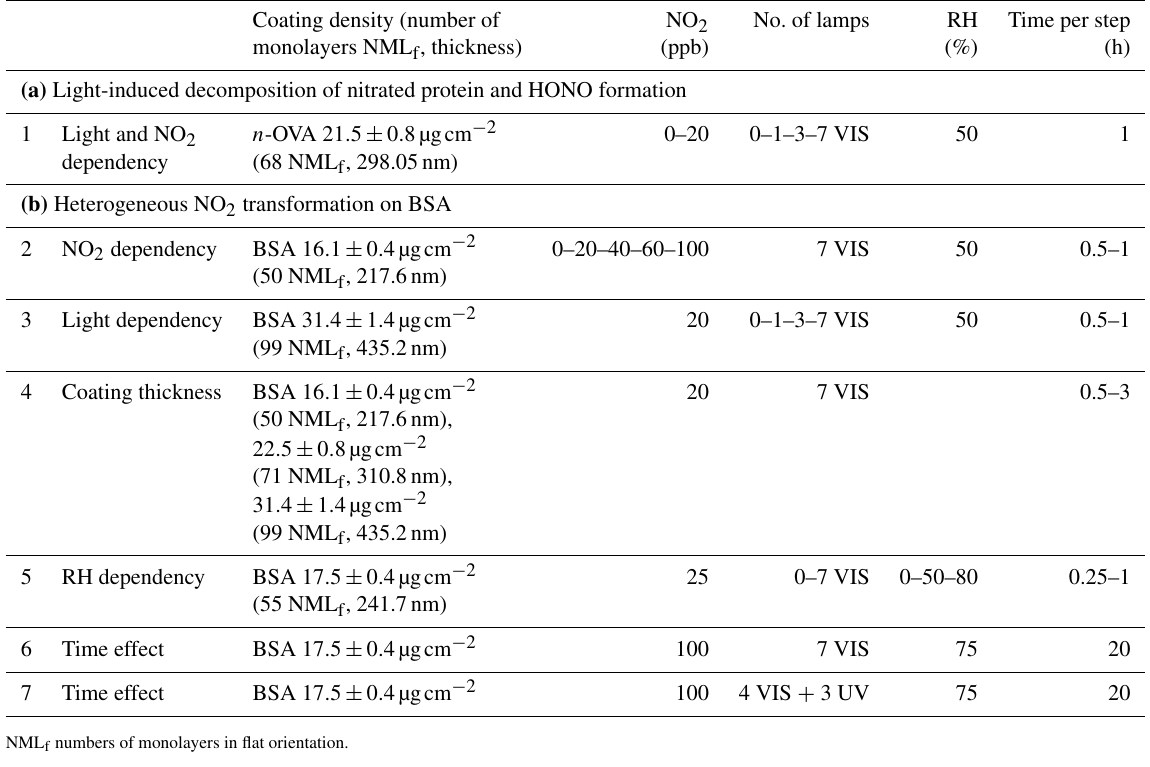
Table 1. Details on the different experiments, aims and experimental conditions (coating, applied NO 2 concentration, number of lights switched on, relative humidity and time for each exposure step).